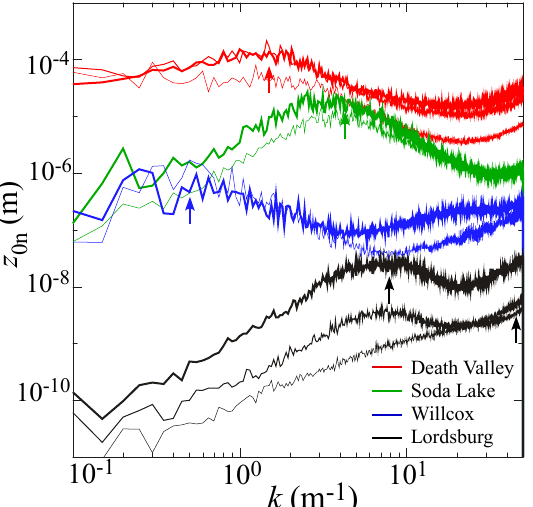
Figure 12. Plots of the contribution of each Fourier mode to the effective roughness length, z 0 n , as a function of k . Arrows point to the range of wavenumbers that contribute most to z 0 .